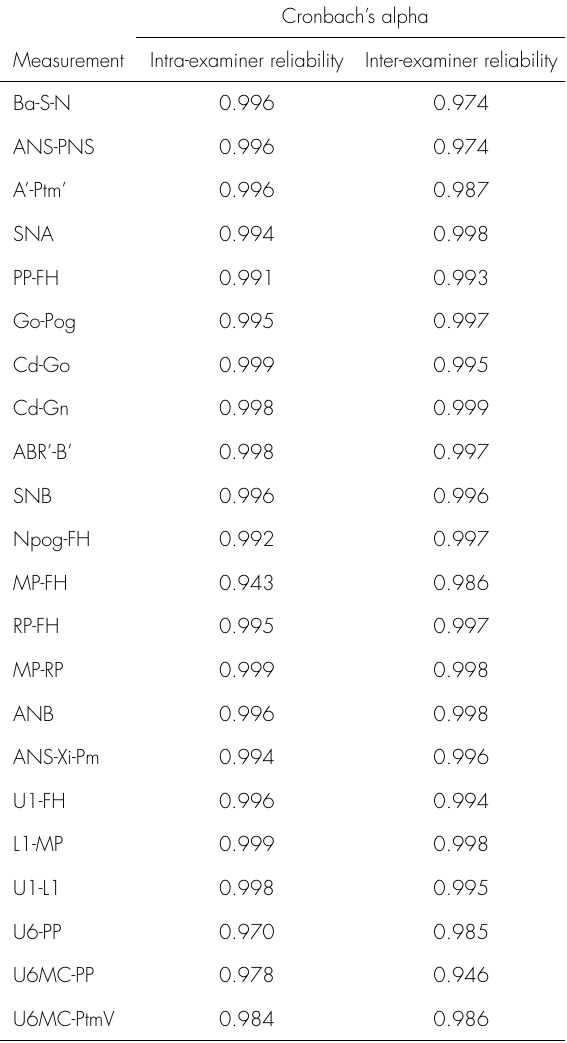
Table III. Results of Cronbach’s